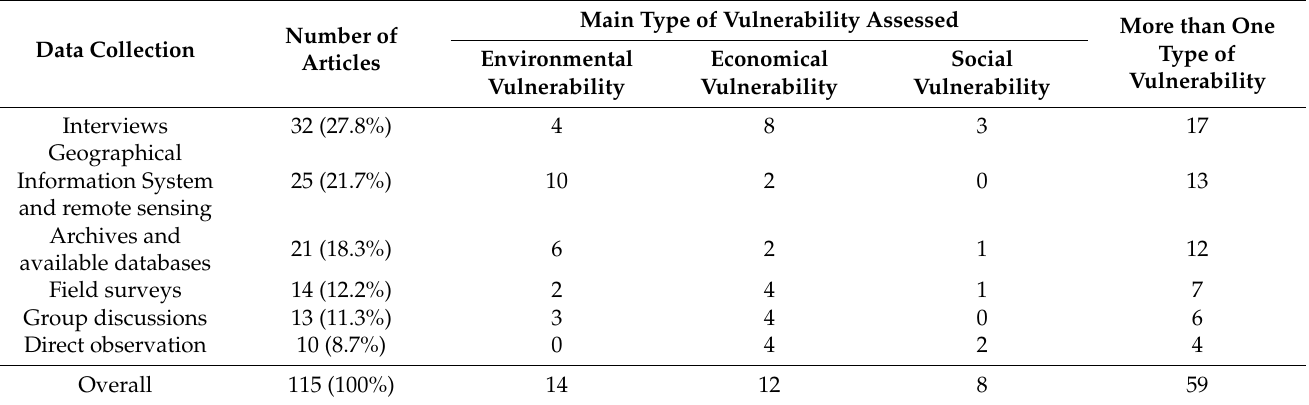
Table 4. Ranking the types of vulnerabilities assessed through different data collection techniques.